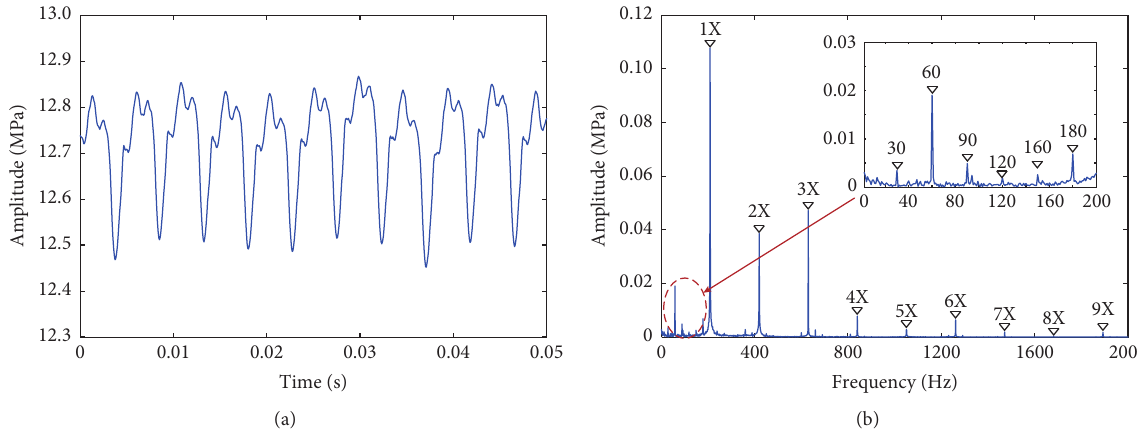
Figure 5: Fluid pressure signals by measurement at 1800r/min. (a) Fluid pressure signals in time domain and (b) fluid pressure signals in frequency